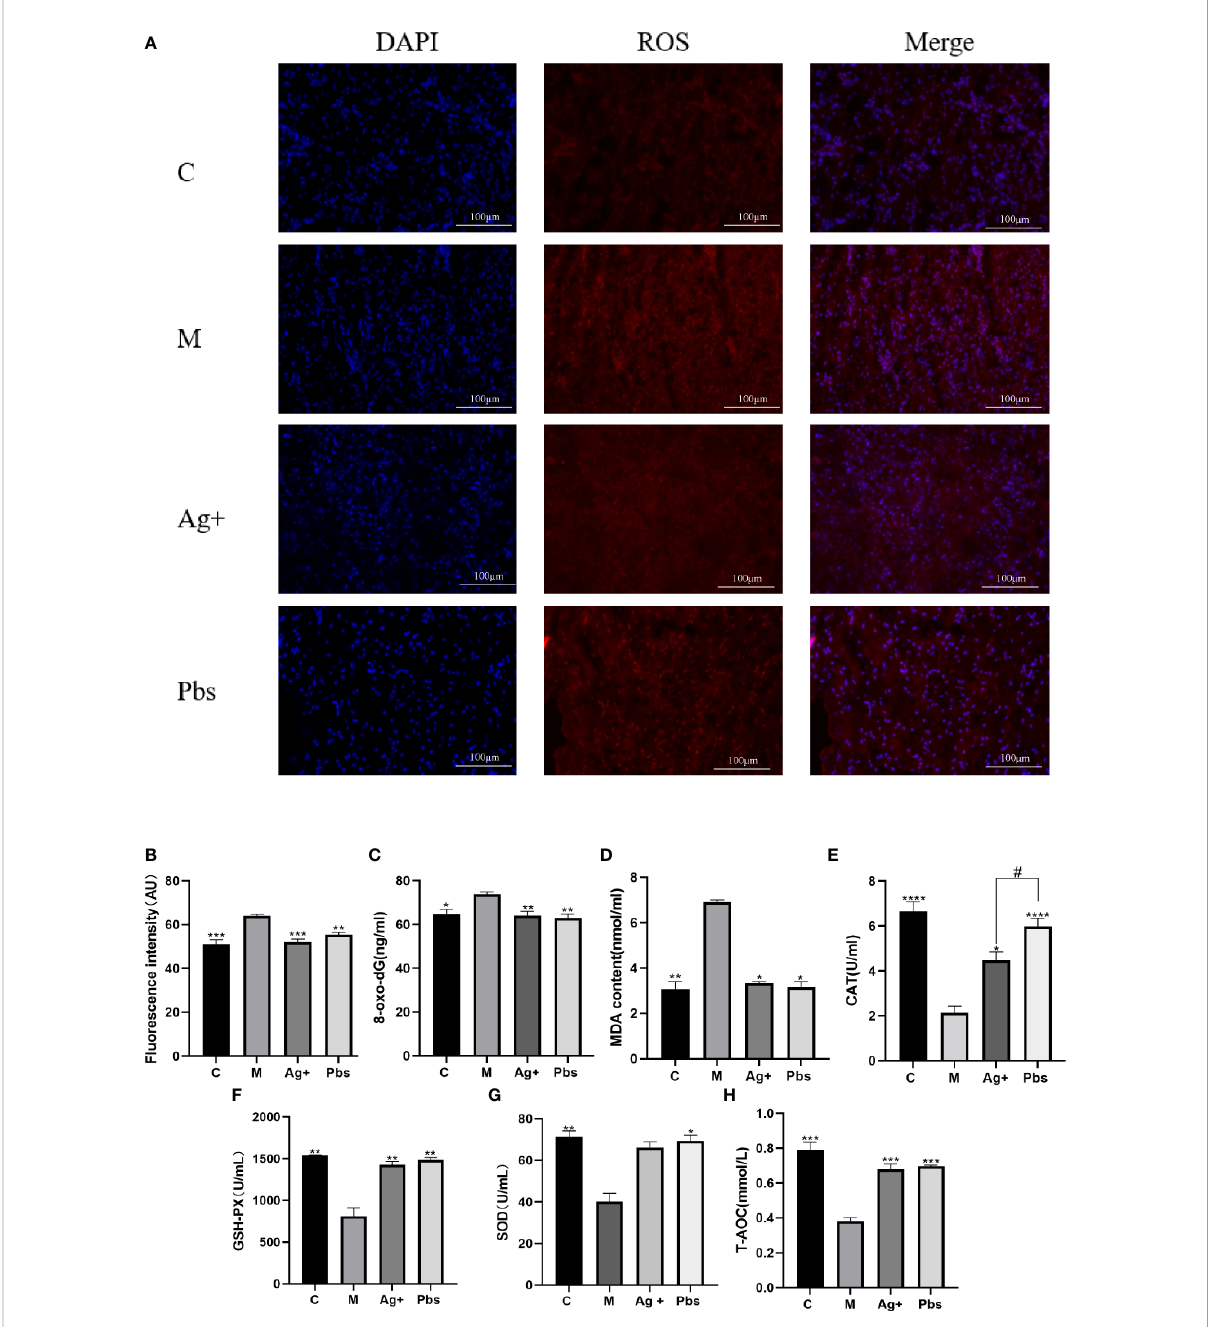
FIGURE 4 Puffball spores reduced oxidative damage by increasing antioxidant capacity. (A, B) Immuno fl uorescent staining reveals a decrease in the fl uorescence intensity in the samples from the puffball spore-treatments group (scale bar = 100 µm; magni fi cation, 400×; n = 3). (C) 8-oxo-dG, (D) MDA, (E) CAT, (F) GSH-PX, (G) SOD, and (H) T-AOC levels in serum from diabetics rats were determined using relevant kits. (Means ± SEM; n = 6; *P < 0.05, **P < 0.01, ***P < 0.001, ****p<0.0001 vs. Model group; #P < 0.05 vs. positive